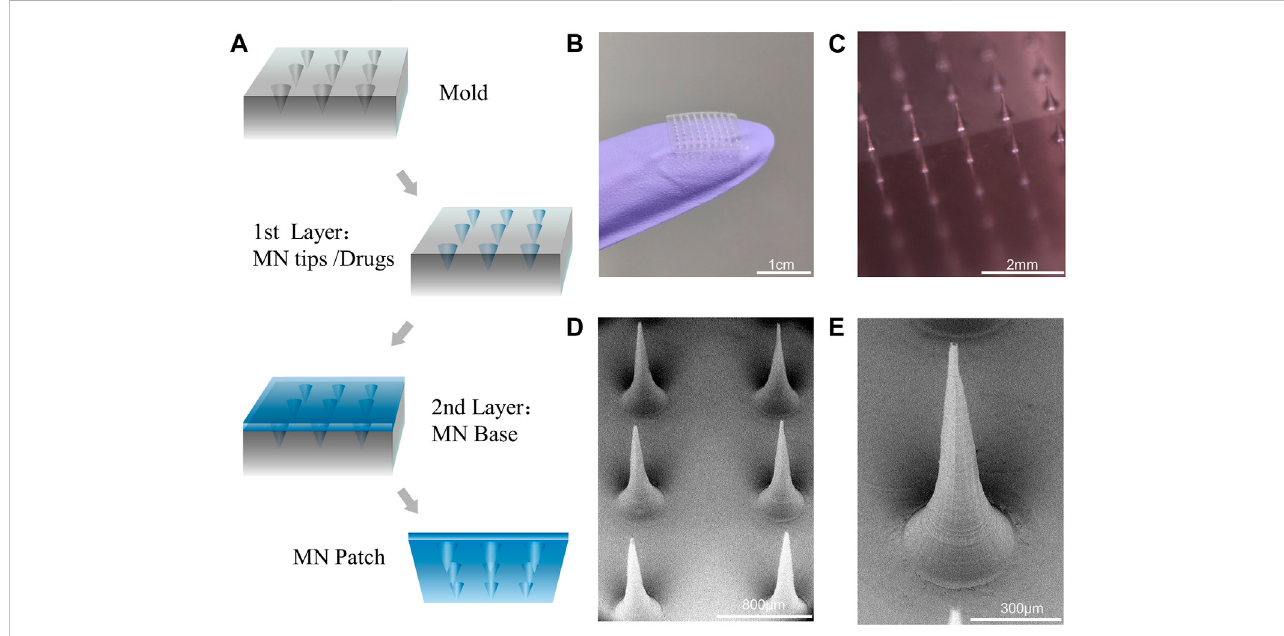
FIGURE 3 MNsfabricationandcharacterization. (A) SchemeofthedesignofMNsbyatwo-steptemplatereplicationmethod. (B,C) OpticalimagesoftheMNs. (D,E) SEM image of MNs and magni fi ed MN tips.